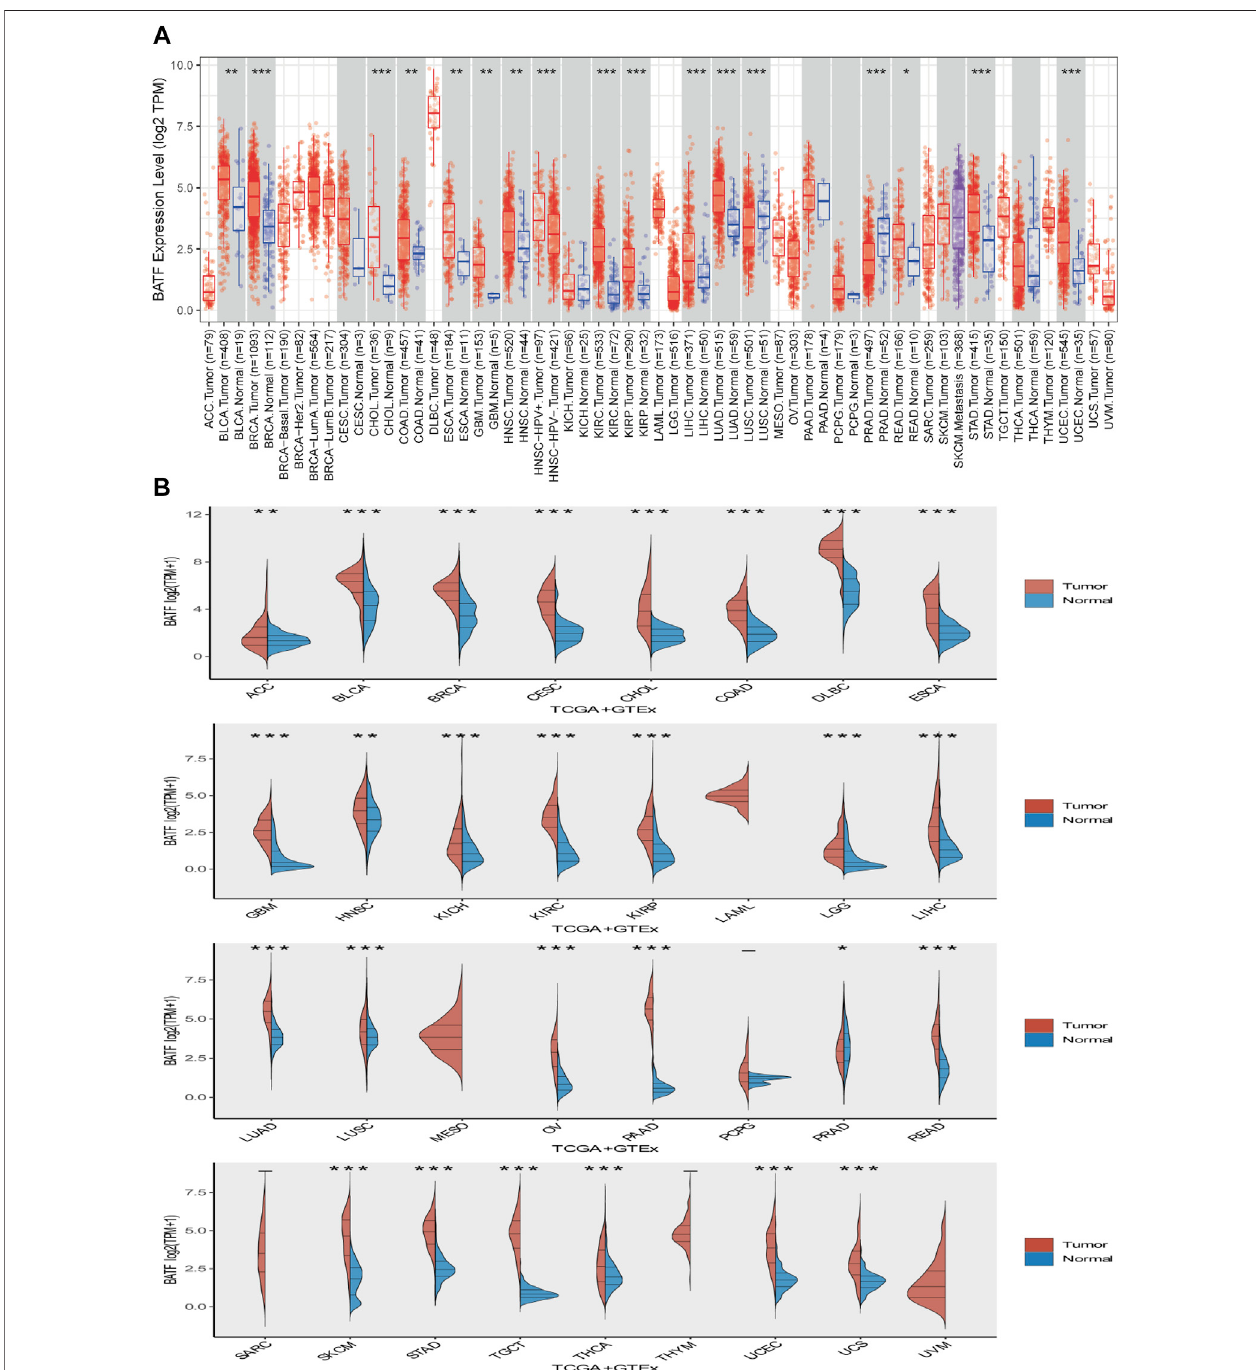
FIGURE 1 | Expression of BATF in pan-cancer. (A) BATF expression levels in tumor tissues and corresponding adjacent tissues. (B) BATF expression levels in tumor tissues and corresponding normal tissues.